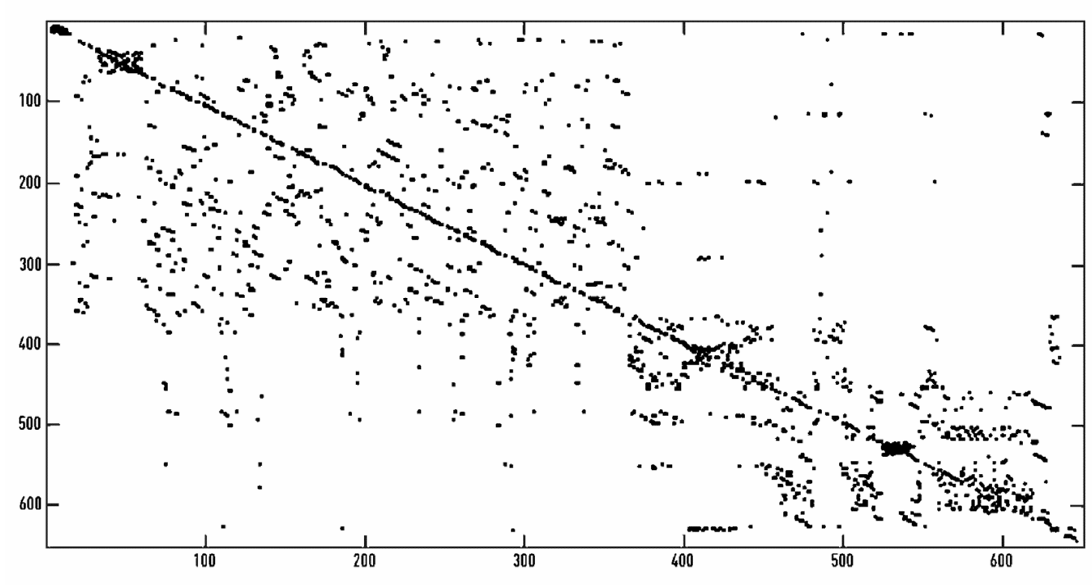
Figure 2. Recurrence plot obtained from a 10-min tachogram. The following HRV RQA values were obtained from this RP: RcRt = 0.0153; DET = 0.5693; ENTR = 0.7314; L mean = 2.56579.